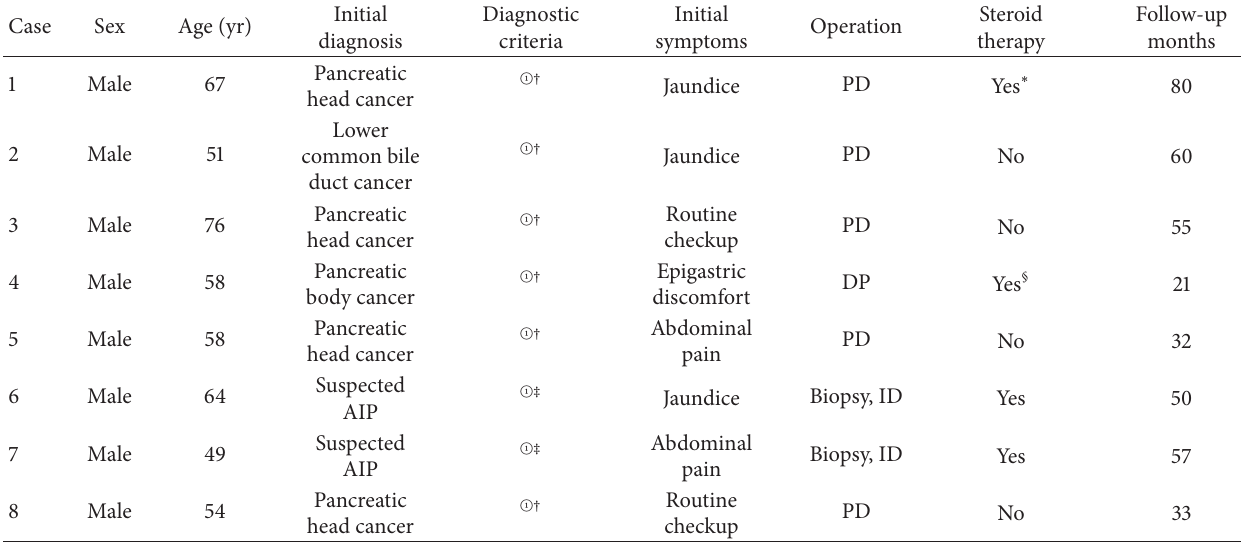
Table 1: Clinic characteristics of AIP patients.